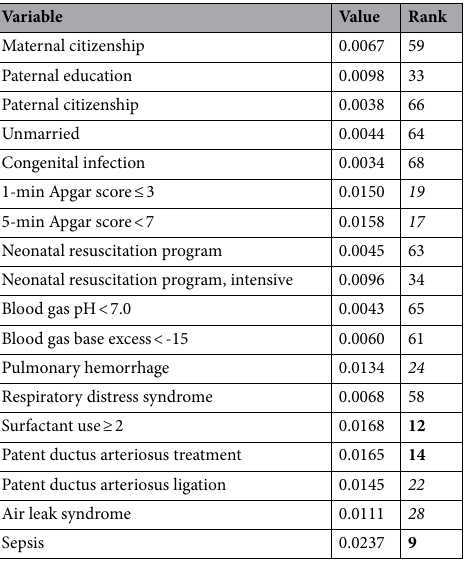
Table 4. Random Forest Variable Importance: Temperature Average for Birth Month, Sepsis Included. Abbreviations: DM, Diabetes mellitus; PROM, Pre-labor rupture of membrane; PM 10 , particulate matter concentration. The ranking of a top-15 (or top-30) predictor is highlighted in bold (or